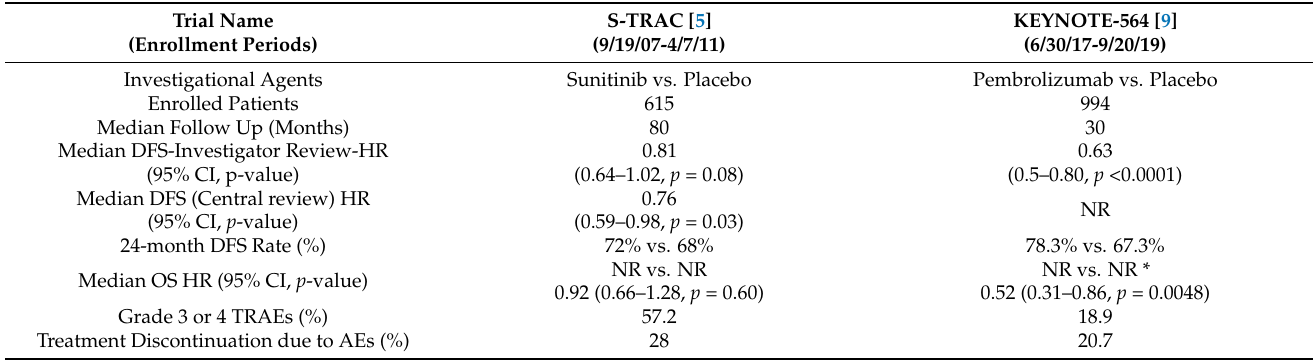
Table 4. Comparison of approved adjuvant treatments after radical nephrectomy for high-risk